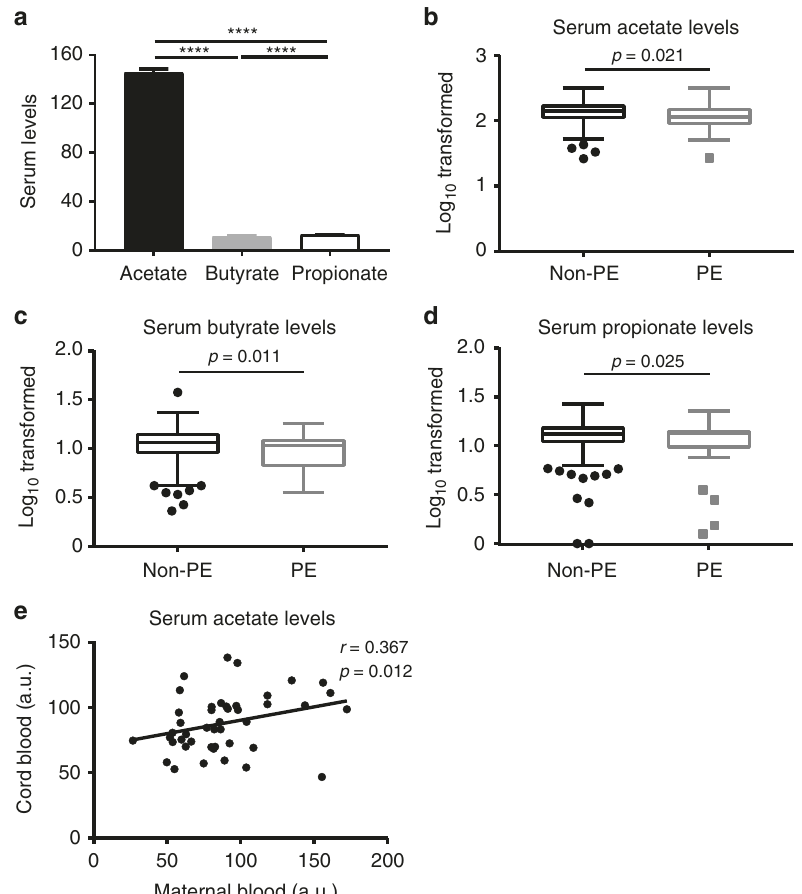
Fig. 5 Serum acetate in healthy pregnancy and preeclampsia. BIS study: a Bar graph showing maternal serum levels (Mean ± SEM, µ M) of acetate, butyrate, and propionate at 28 weeks of pregnancy ( n = 324) (RM one-way ANOVA with Tukey ’ s multiple comparisons test, with the Greenhouse-Geisser correction). Box and whisker (Tukey) plots showing evidence of associations between lower ( b ) acetate, ( c ) butyrate, and ( d ) propionate levels ( µ M, Log base 10 transformed) from women with subsequent preeclampsia (PE, n = 31) and women without preeclampsia (non-PE, n = 293). p- values calculated using weighted logarithmic regression. Nepean cohort 4 ( e ): Scattered dot plot showing the relative serum acetate levels in paired term maternal peripheral blood and cord blood ( n = 46) (samples were collected at full term delivery). The acetate levels were based on peak heights from the NMR spectra normalized to the total intensity. a.u. = arbitrary units (values are divided by 1000). Pearson r = 0.367, p = 0.012; Spearman rho = 0.416, p =